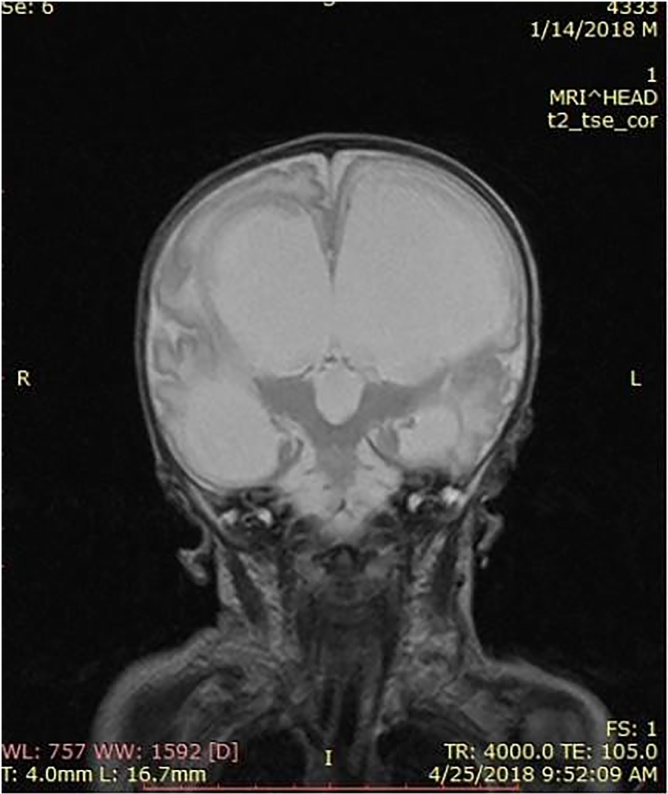
MRI scan, coronal view, delineating the significant enlargement of the frontal horns and the significant gyral hypoplasia.